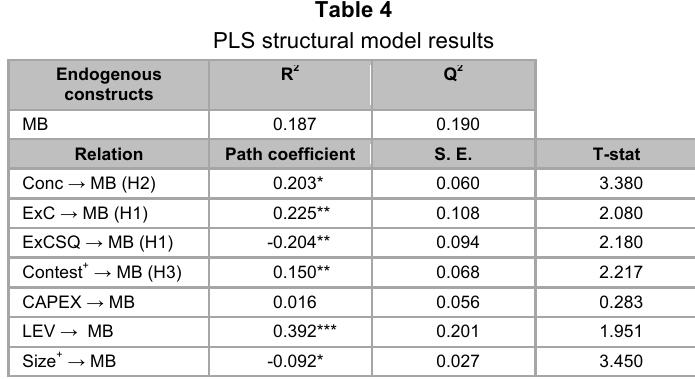
PLS structural model